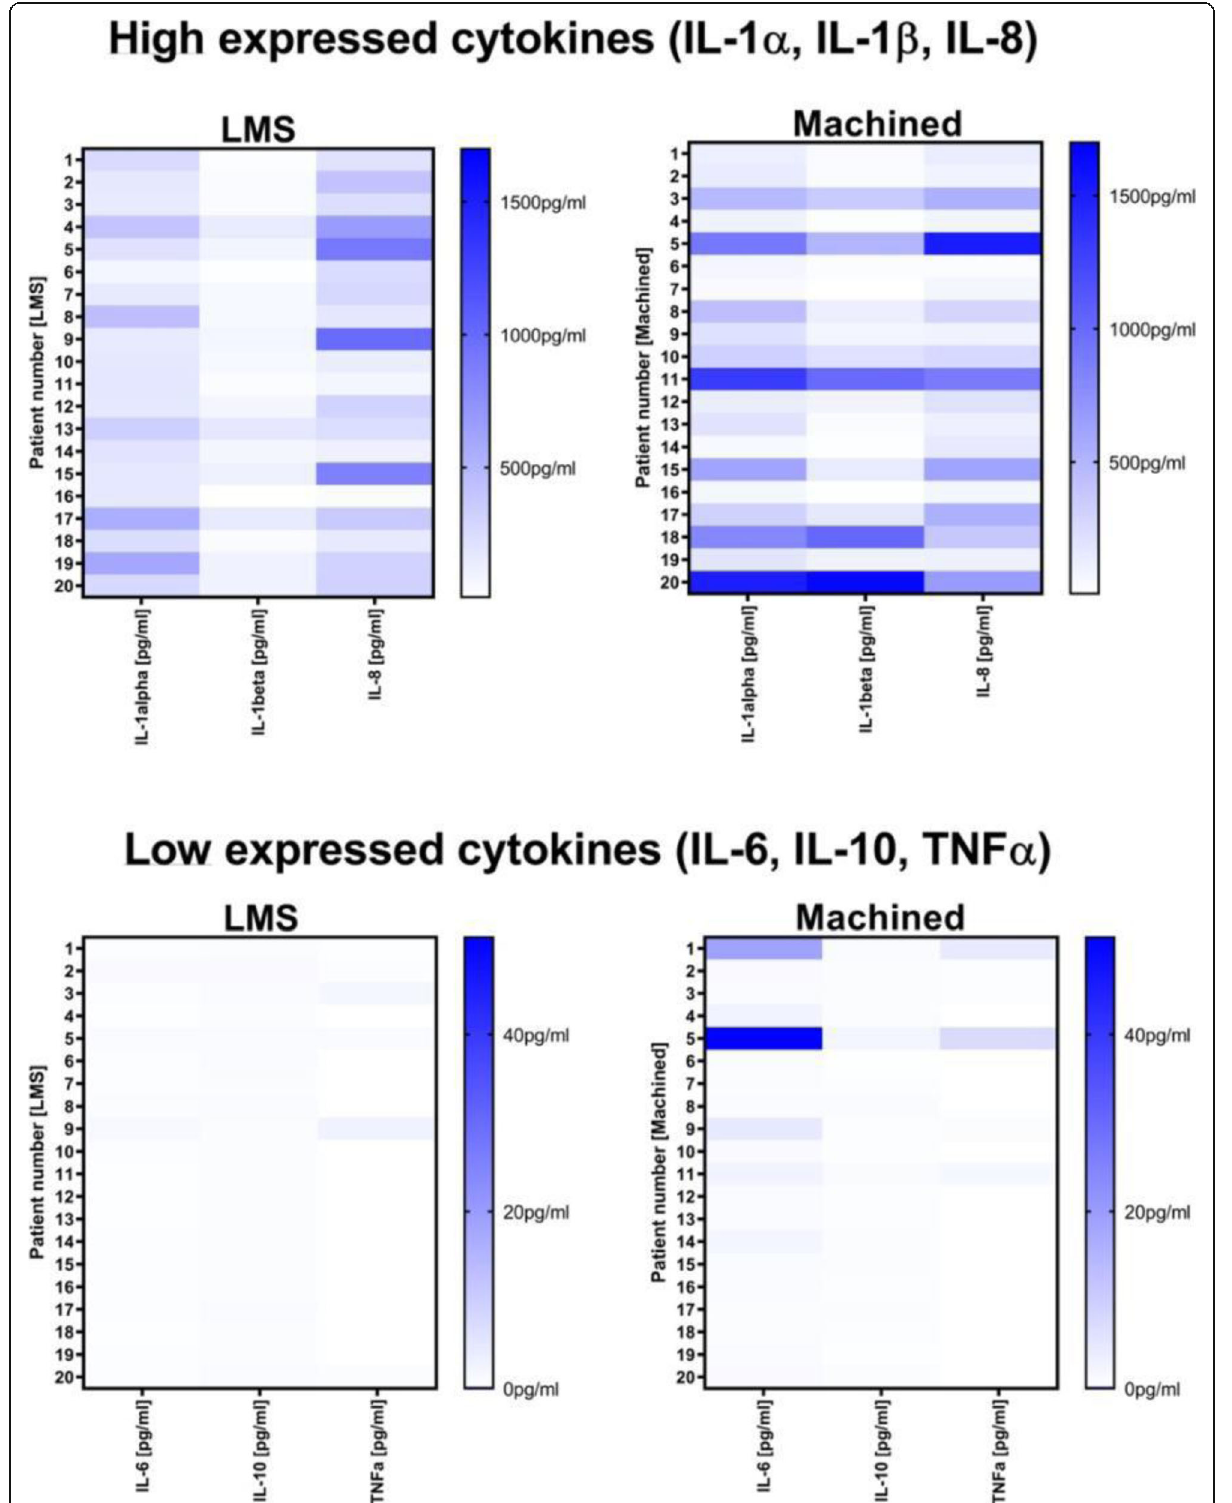
Fig. 4 Cytokine analysis of IL-1 α , IL-1 β , IL-6, IL-8, IL-10, and TNF- α for LMS vs M